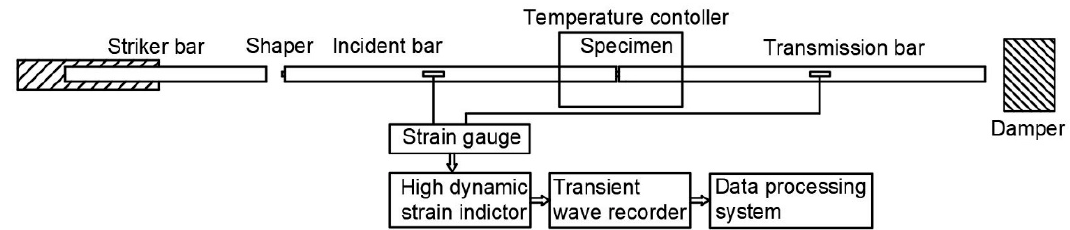
Figure 1. Schematic of the SHPB system with temperature controller.